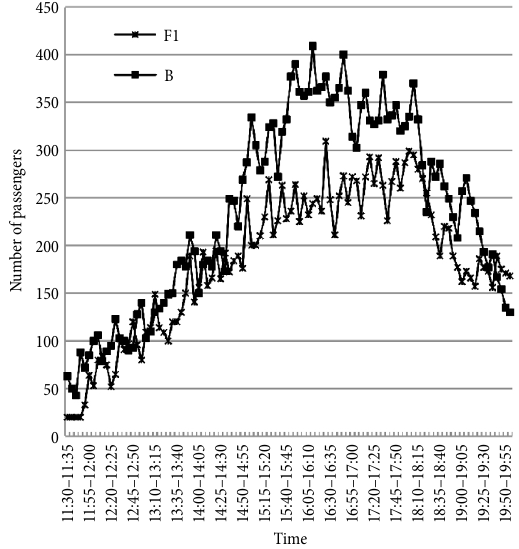
Fig. 1. Changes of the passenger flows into XS with